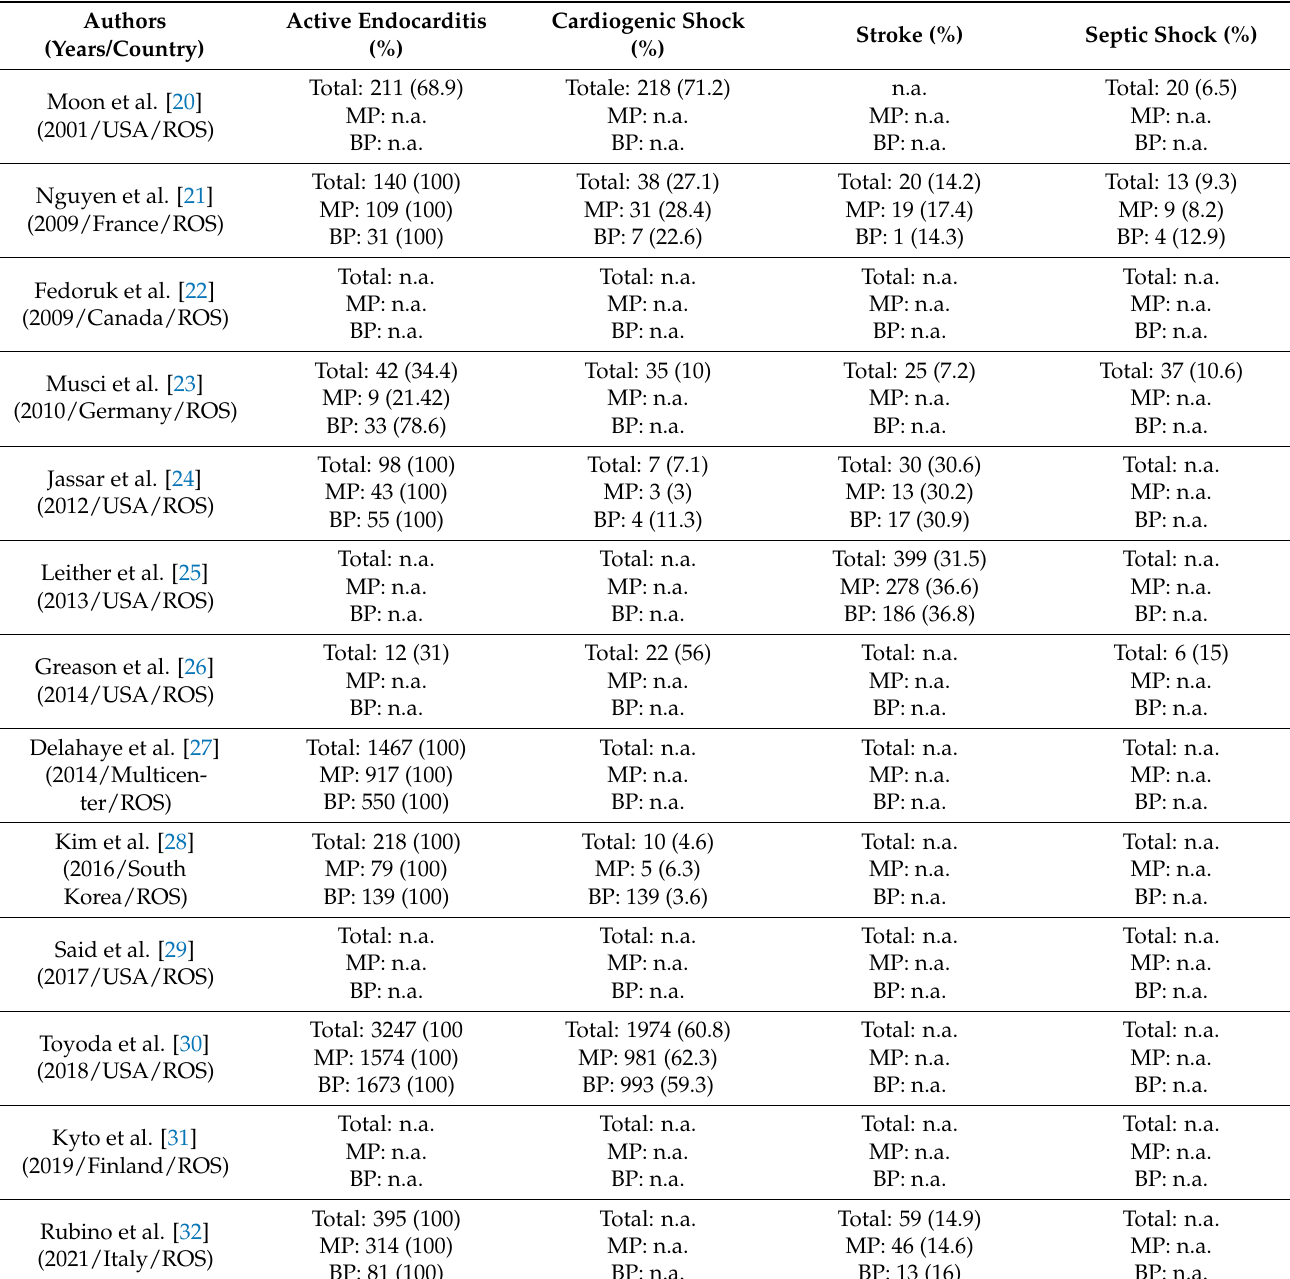
Table 2. Study typology and patients’